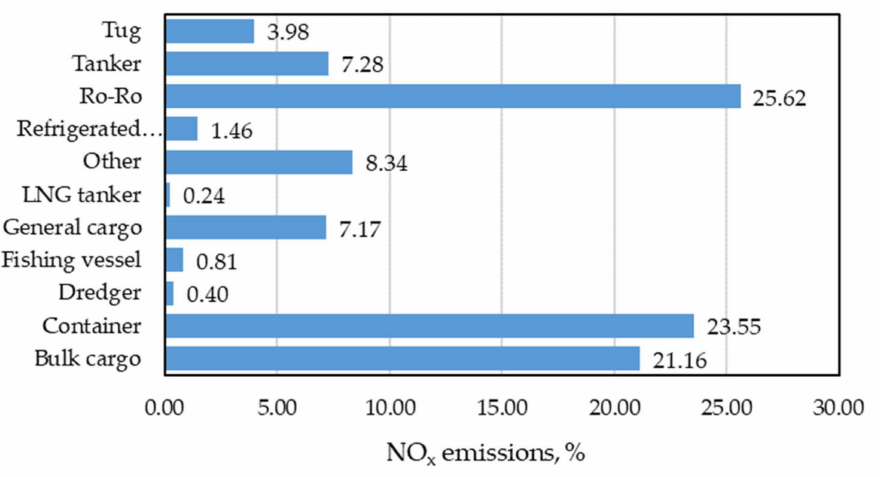
Figure 3. Emissions of ships entering the port of Klaipeda (%) by their type.